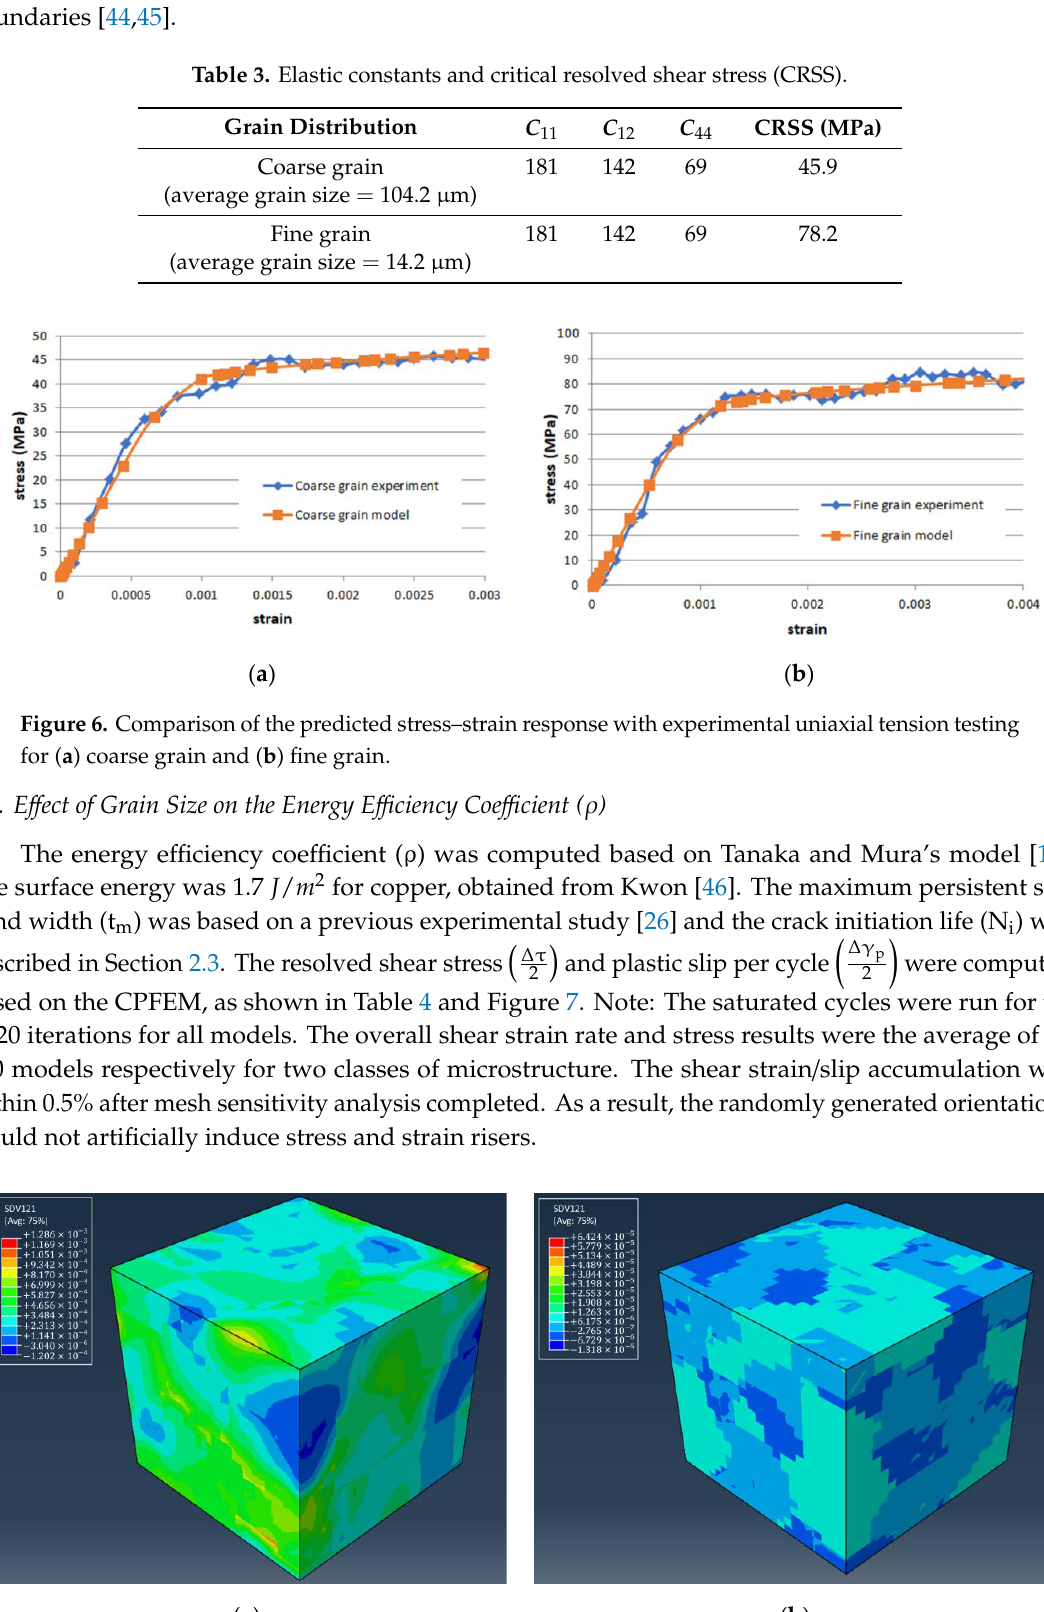
Figure 8. Computed energy efficiency coefficient for different grain sizes of polycrystal copper. 3.3. Crack Initiation Prediction Improvement The energy efficiency coefficient was computed to be a constant for a specific class of material grain sizes. By using this approach, the shear stress amplitude and plastic slip per cycle at the localized weakest location could be computed to reduce overall inconsistencies and artificially induced stress risers incorporated as a result of unrepresentative volumes. Computing a localized energy efficiency coefficient can considerably improve fatigue crack initiation estimation. In order to demonstrate the capability of the new model, its predicted crack initiation was compared with those of previously existing models by Fine and Bhat [14] and Voothaluru and Liu [16,17], as shown in Table 5. The newly proposed model demonstrated improvement of up to 97.78% compared to Fine and Bhat’s model, which underestimated the fatigue crack initiation as a result of not including the localized microstructure at the weakest region. In addition, the new model improved accuracy up to 10.06% compared with Voothaluru and Liu’s model by including the effect of grain size on the energy efficiency coefficient. Thus, it can be seen